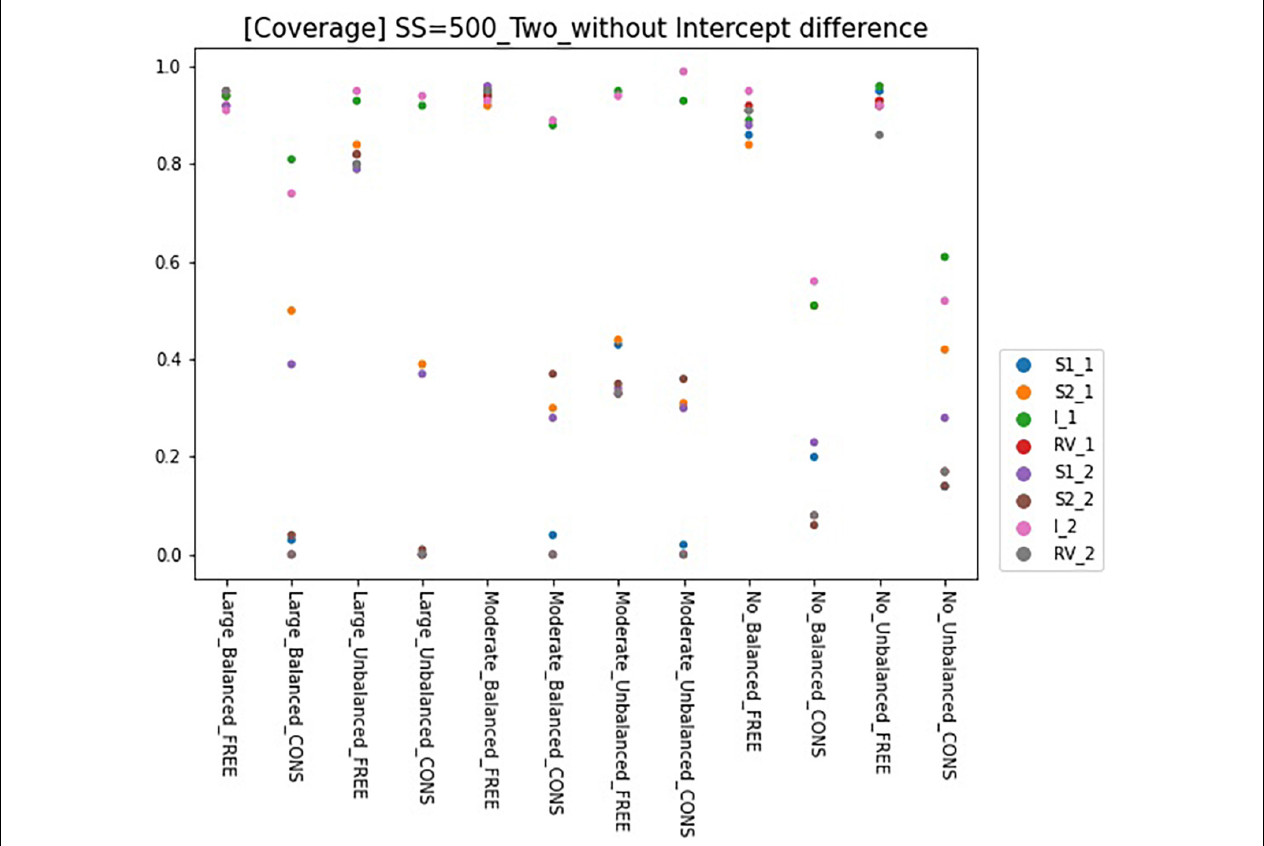
FIGURE 7 | Coverage of 95% confidence interval of two-predictor models (sample size = 500, without intercept difference). Free, residual variances freely estimated; Cons, residual variances equally constrained; SS, sample size; CP, class proportion; RV, the disparity in the magnitude of class-specific residual variances; C1_S1, slope for x1 in class 1; C1_S2, slope for x2 in class 1; C1_I, intercept in class 1; C1_RV, residual variance for class 1; C1_S1, slope for x1 in class 2; C1_S2, slope for x2 in class 2; C2_I, intercept in class 2; C2_RV, residual variance for class